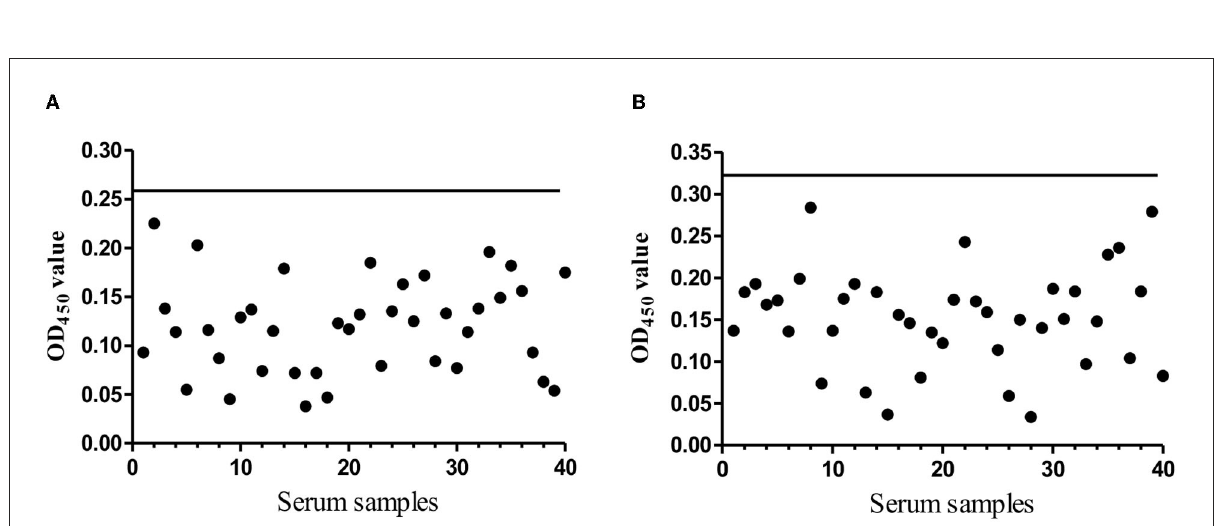
FIGURE3 The cut-off value determination. (A) The evaluation of the cut-off OD 450 value of the indirect Rep based ELISA. The black solid line presents the OD 450 cut-off value (0.262). (B) The evaluation of the cut-off OD 450 value of the indirect Cap based ELISA. The black solid line presents the OD 450 cut-off value